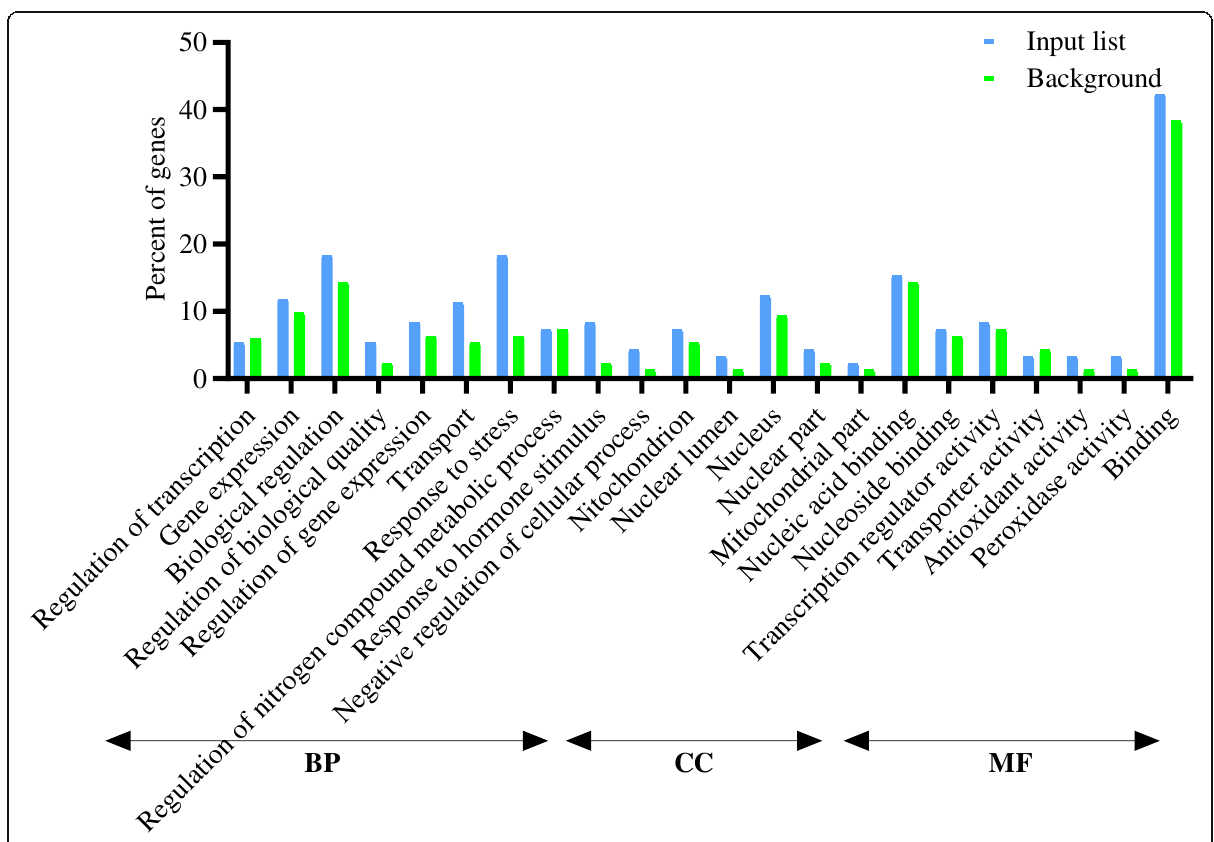
Fig. 2 Gene Ontology enrichment analysis (BP, biological processes; CC, cellular components; and MF, molecular function) of differentially expressed genes ( ≤ 5 and ≥ − 5) at drought stress conditions in vegetative stage barley based on microarray data using